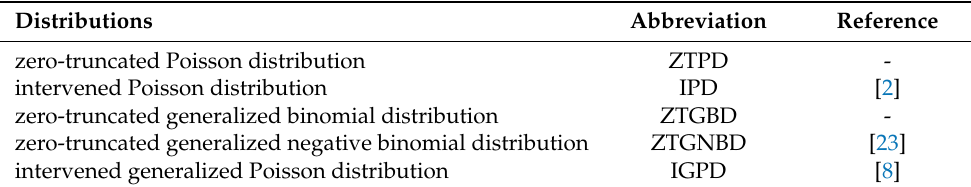
Table 4. The considered competitive distributions.